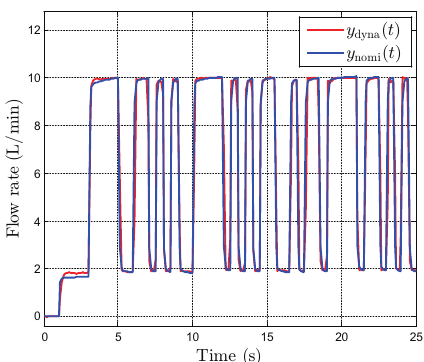
Figure 9. Comparison of the measured output y dyna ( t ) and the output y nomi ( t ) of the identified nominal model.